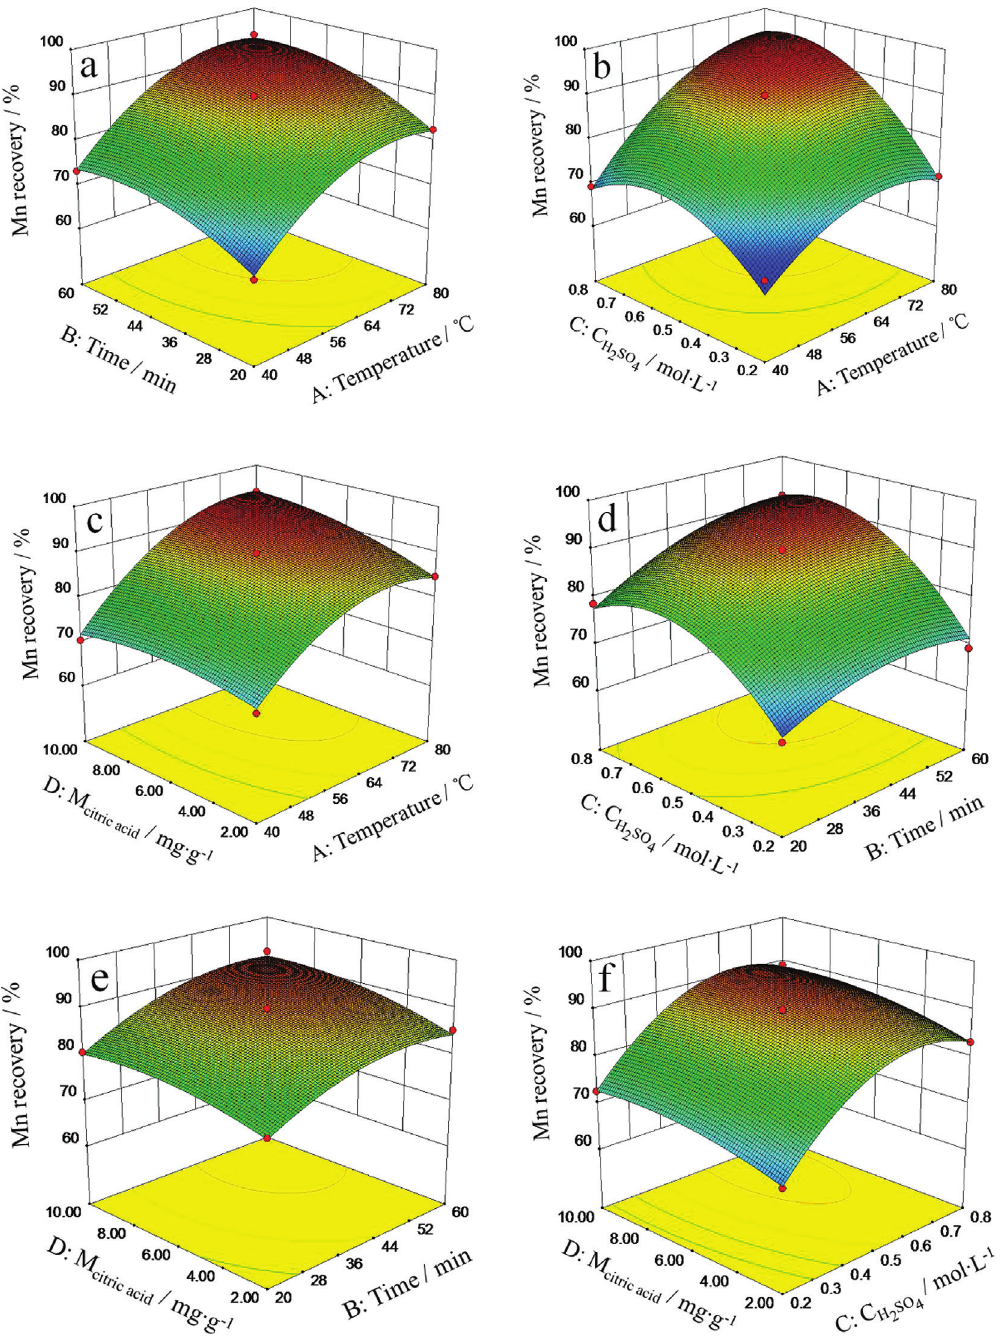
), time ( X ), H SO concentration ( X 1 2 2 4